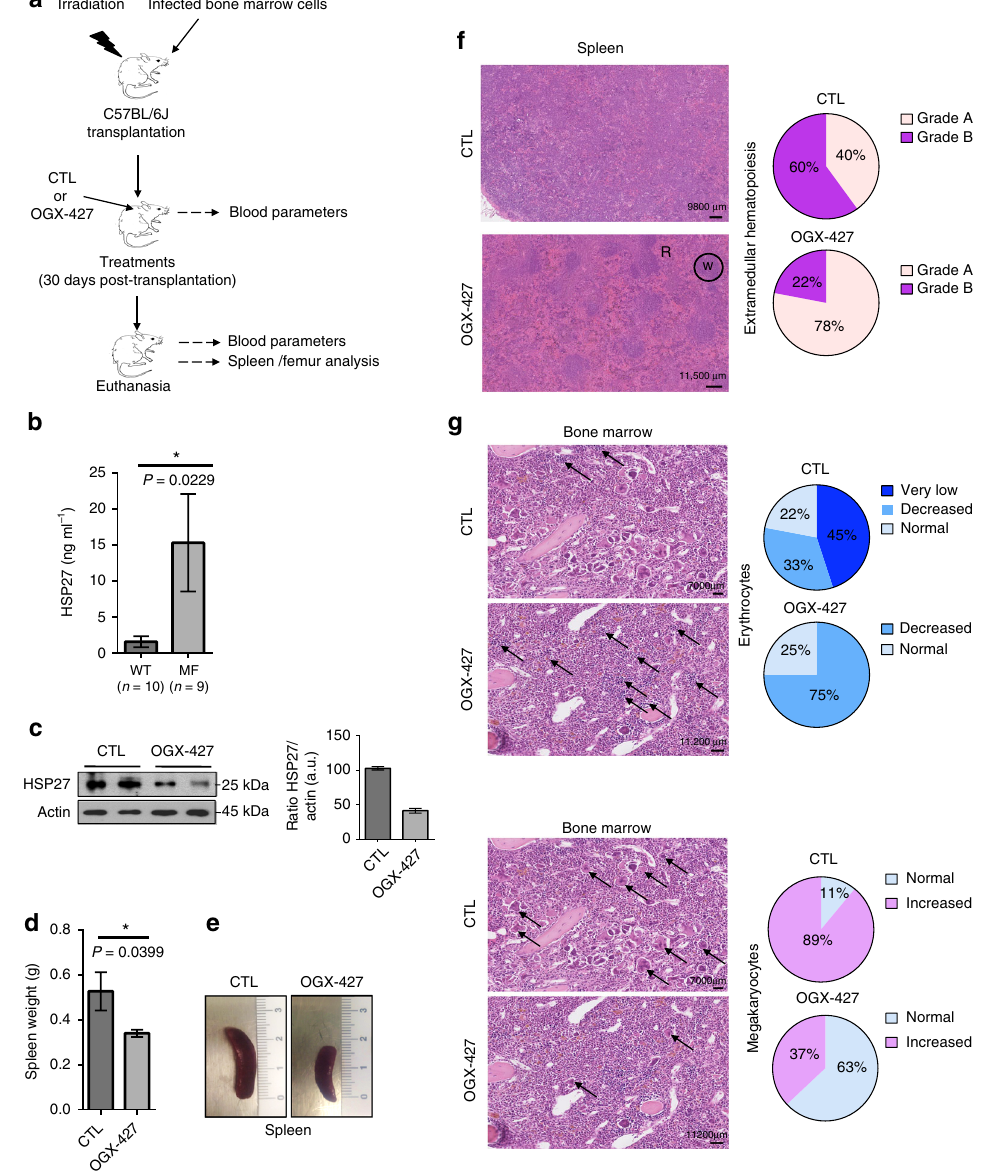
Fig. 1 HSP27 downregulation impairs myelo fi brosis progression in a TPO high murine model. a In vivo strategy of HSP27 inhibition using OGX-427, or a scrambled oligonucleotide control (CTL) injected intraperitoneally 3 times a week at a dose of 10 mg kg − 1 in a TPO high murine model of myelo fi brosis (MF). Mice were 2 – 4 months old. b Expression level of HSP27 proteins in the serum of TPO high mice ( n = 9) compared with healthy mice (WT, n = 10) measured by ELISA assay. P value was calculated using the Mann – Whitney test. * P < .05. Error bars represent ±s.e.m. c Western blot analysis of HSP27 in splenocytes (whole cell lysate) of MF mice treated with OGX-427 or CTL. Actin served as the loading control. Bar graphs show quanti fi cation of mean relative amount of the proteins ( n = 2 per group). Uncropped blots presented in Supplementary Fig. 7a d Spleen weight was evaluated in mice ( n = 9 per group). Outcomes of the two treatments were compared using the Mann – Whitney test. * P < .05. Error bars represent ±s.e.m. e Representative picture of spleen size of MF mice treated with CTL or OGX-427. f Left panel, haematoxylin and eosin-stained spleen sections revealed hyperplasia of the red pulp (R) in MF mice and partial restoration of the white pulp (W) territories in OGX-427-treated mice. Right panel, assessment of the grade of extramedullary haematopoiesis (EMH), from spleen sections in 18 killed mice. Pie chart: Grade A (light pink): diffuse EMH invasion. Grade B (purple colour): diffuse EMH invasion with atrophy of white pulp. Images were obtained using a Nanozoomer scanner (Hamamatsu, France) at ×23 magni fi cation and Calopics software. g Left panel, histology of bone marrow sections after haematoxylin and eosin staining. Right panel, Pie chart representing percentages of mice according to erythrocyte (right upper panel) and megakaryocyte counts (right lower panel) from bone marrow sections of 18 killed mice: very low cell number (dark blue), decreased cell number (azure blue), normal cell number (light blue) and increased cell number (pink). Arrows show erythrocyte foci and megakaryocytes. Images were obtained using a Nanozoomer scanner (Hamamatsu, France) at ×13 magni fi cation and Calopics